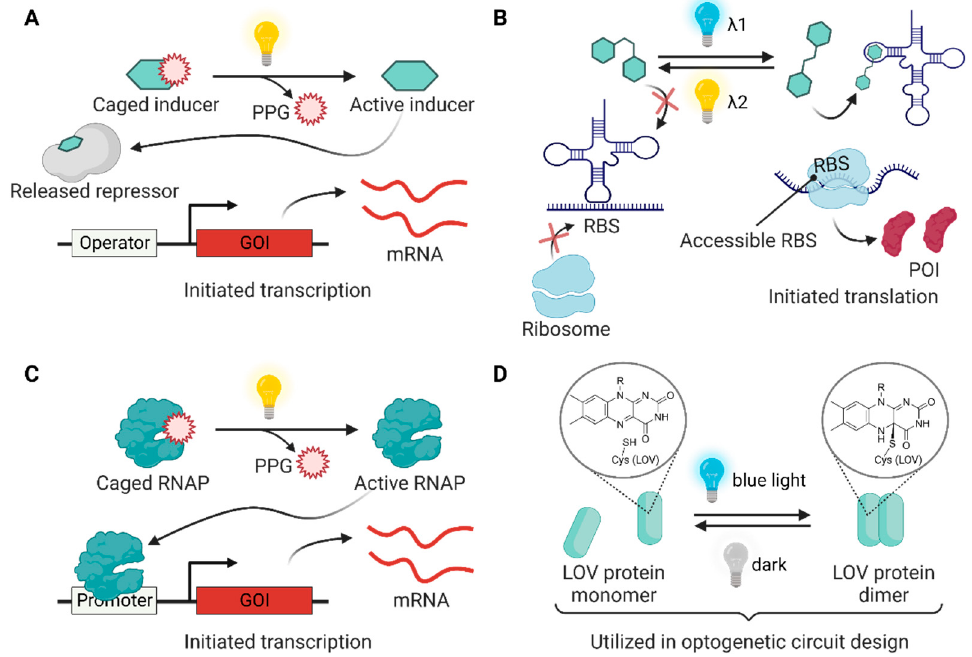
Figure 3. Light-driven regulation modules utilized in bacterial engineering. ( A ) Chemical inducers can be inactivated by installing a photocleavable protecting group (PPG) and activated by irradiating light to unmask the PPG for the induction of gene expression. ( B ) A photoswitchable small molecule (e.g., stiff-stilbene and azobenzene) non-covalently binds to riboswitches, leading to the reversible expression of GOI under the controlled exposure of two different light signals. ( C ) A genetically encoded photocaged non-canonical amino acid (ncAA) allows the construction of photocaged RNAP, whose function can be triggered by light for GOI expression. ( D ) Some LOV domains (e.g., VVD, EL222, and Magnets) dimerize when flavin cofactor forms a covalent bond with the active-site cysteine under blue light irradiation. In the dark, the structures return to their original state through thermal processes. The photocycle of the LOV domains can be utilized in optogenetic circuit design.